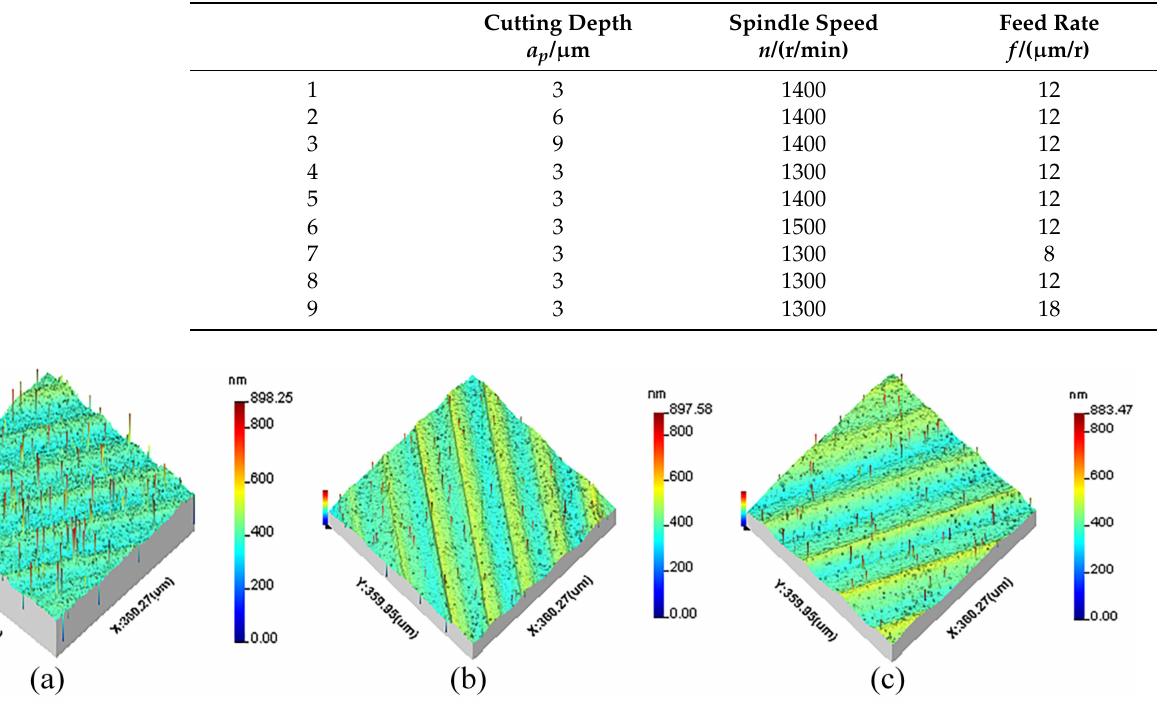
Figure 1. The original 3D surface topography of different cutting depths: ( a ) a p = 3 µ m, ( b ) a p = 6 µ m, ( c ) a p = 9 µ m.